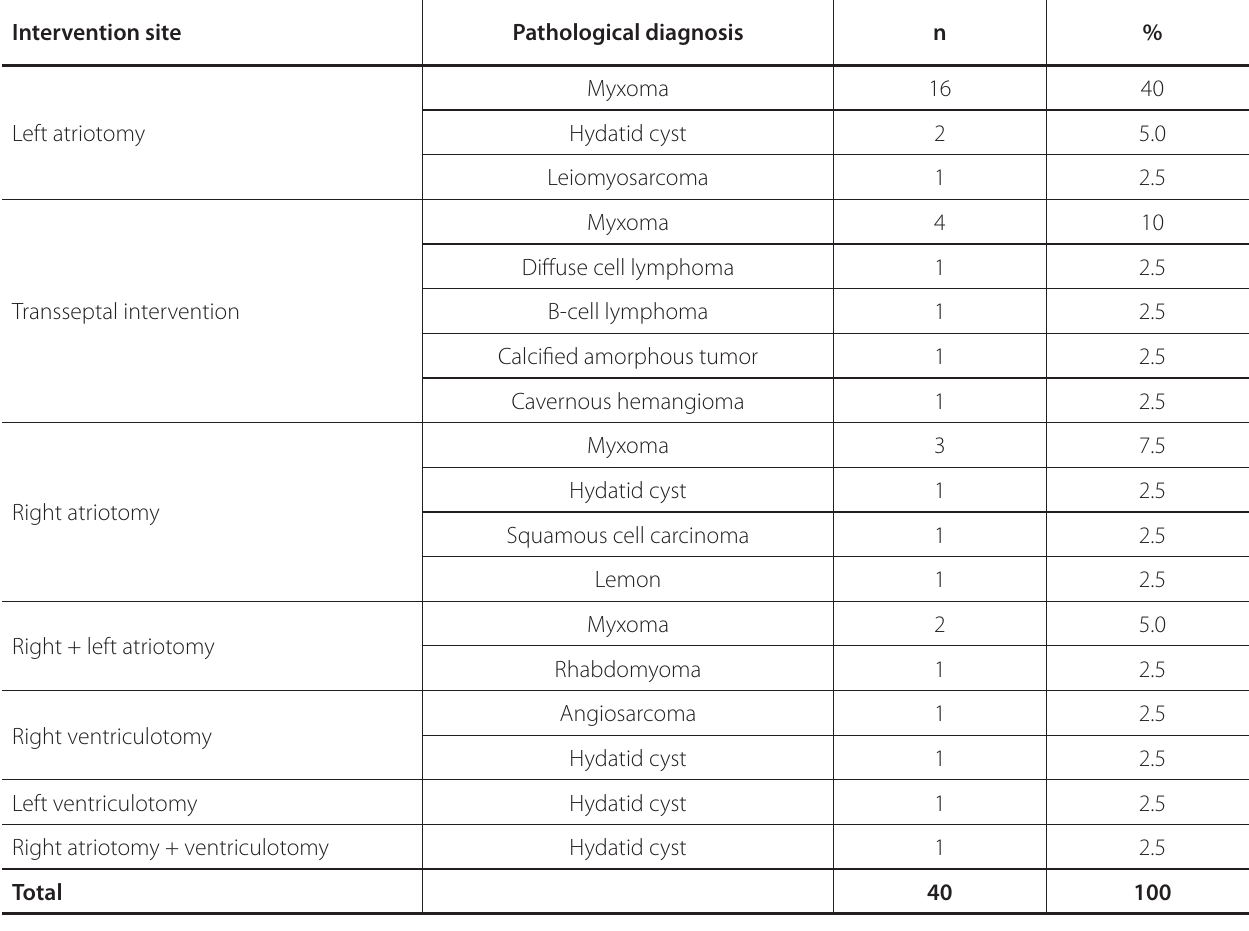
Table 2 . Site of surgical intervention and pathological diagnosis. Intervention